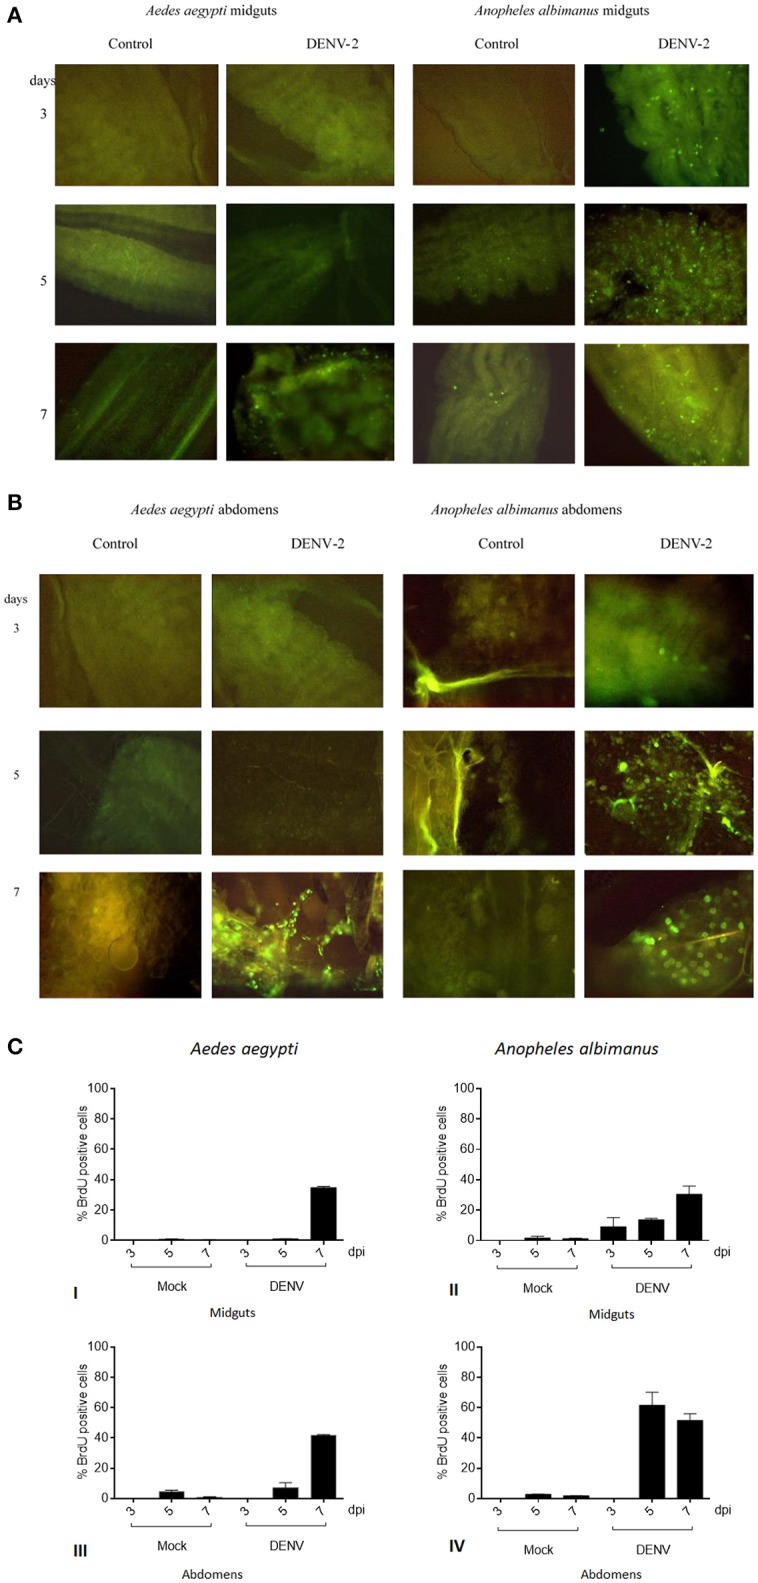
(A) DNA synthesis in mosquitoes challenged with Dengue virus by in situ immunofluorescence assay. Viral challenged tissues respond by endoreplicating genomic DNA. Control challenged tissues show no evidence of DNA synthesis. Anopheles albimanus was used as a positive control for DNA synthesis. Intense DNA synthesis is observed in Anopheles albimanus at earlier times, meanwhile Aedes aegypti response delays until 7 days. Aedes aegypti midguts control (erythrocytes plus MEM media) and DENV challenged. Anopheles albimanus midguts control and DENV challenged. (B) DNA synthesis in mosquitoes challenged with Dengue virus by in situ immunofluorescence assay. Aedes aegypti abdomens control (erythrocytes plus MEM media) and DENV challenged. Anopheles albimanus abdomens control and DENV challenged. (C) DNA synthesis in mosquitoes challenged with Dengue virus by in situ immunofluorescence assay. BrdU positive cell percentage per microscope field: of Aedes aegypti midgut cells (I) or abdomen cells (III) 3, 5, and 7 days post blood (mock) or blood plus 1 × 108 FFU/mL DENV alimentation. BrdU positive cell percentage per microscope field: of Anopheles albimanus midgut cells (II) or abdomen cells (IV) 3, 5, and 7 days post blood (mock) or blood plus 1 × 108 FFU/mL DENV alimentation.